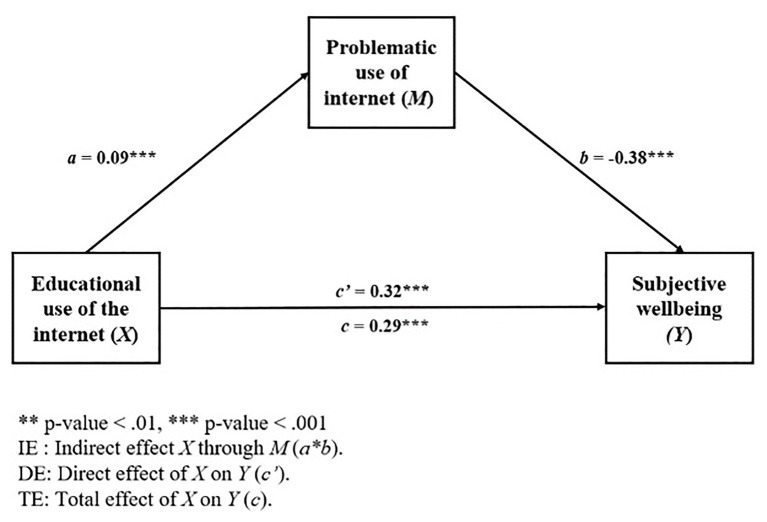
Mediational model 3.